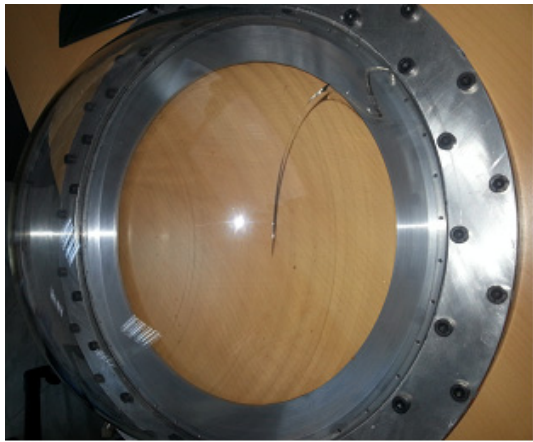
Figure 3: One example of the fracture of glass component; crack initiated from the zone close to glass-mount contact area.